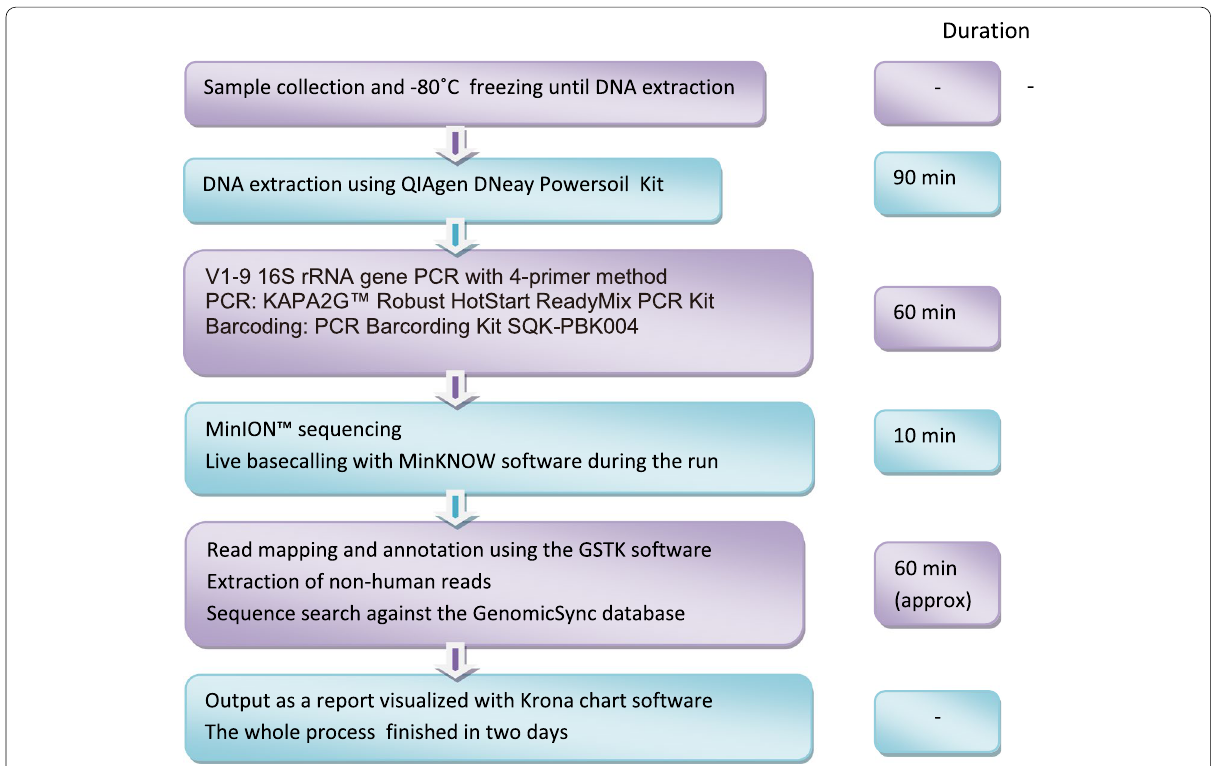
Fig. 1 Workflow of 16S rRNA amplicon sequencing with the MinION ™ platform and bioinformatics